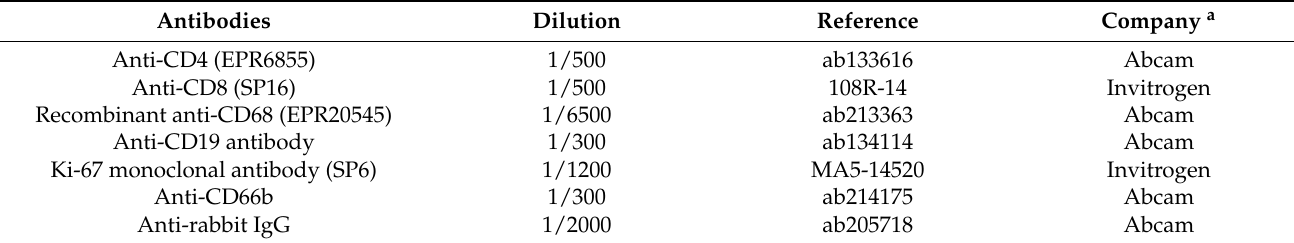
Table 2. List of antibodies and